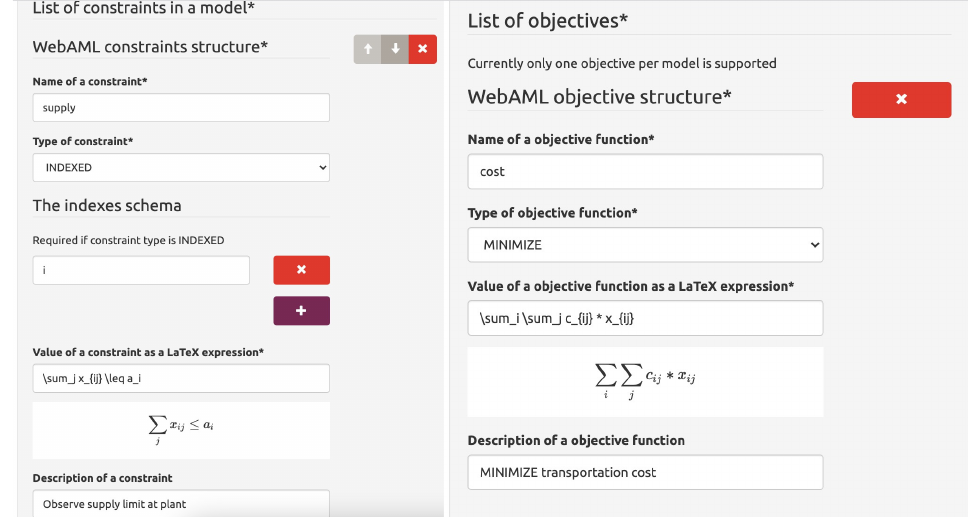
Figure 3. Screenshot of the user interface for the WebAML Optimization System. Supply constraint and objective function of transportation problem are presented.